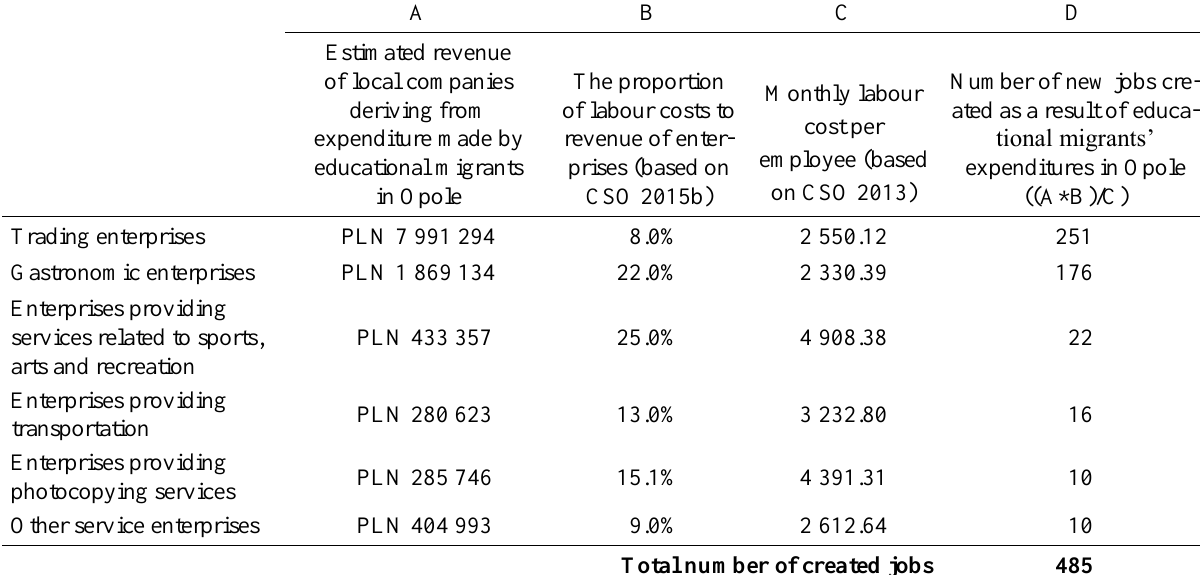
Table 1. Estimation of the number of new jobs created as a result of educational migrants’ expendi- tures in Opole A